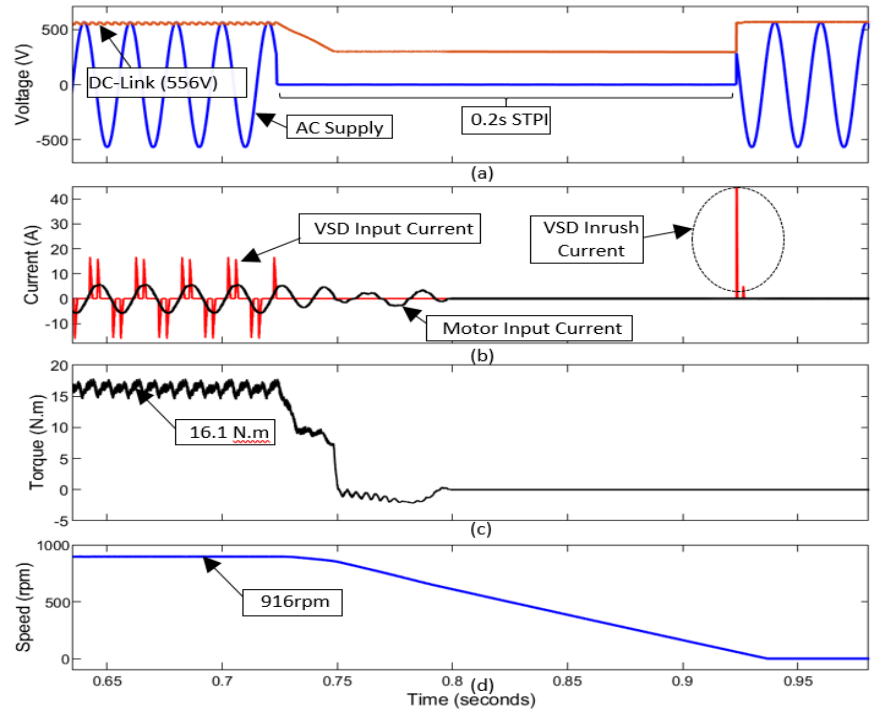
Figure 7. Simulation results without compensation of the dc-link, ( a ) supply and the dc bus voltage, ( b ) dc-link current and moto input current, ( c ) load torque and ( d ) motor speed.